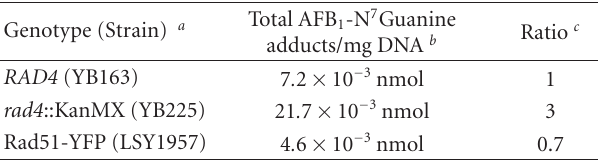
Table 2: AFB1-N 7 Guanine adducts in wild type and the rad4